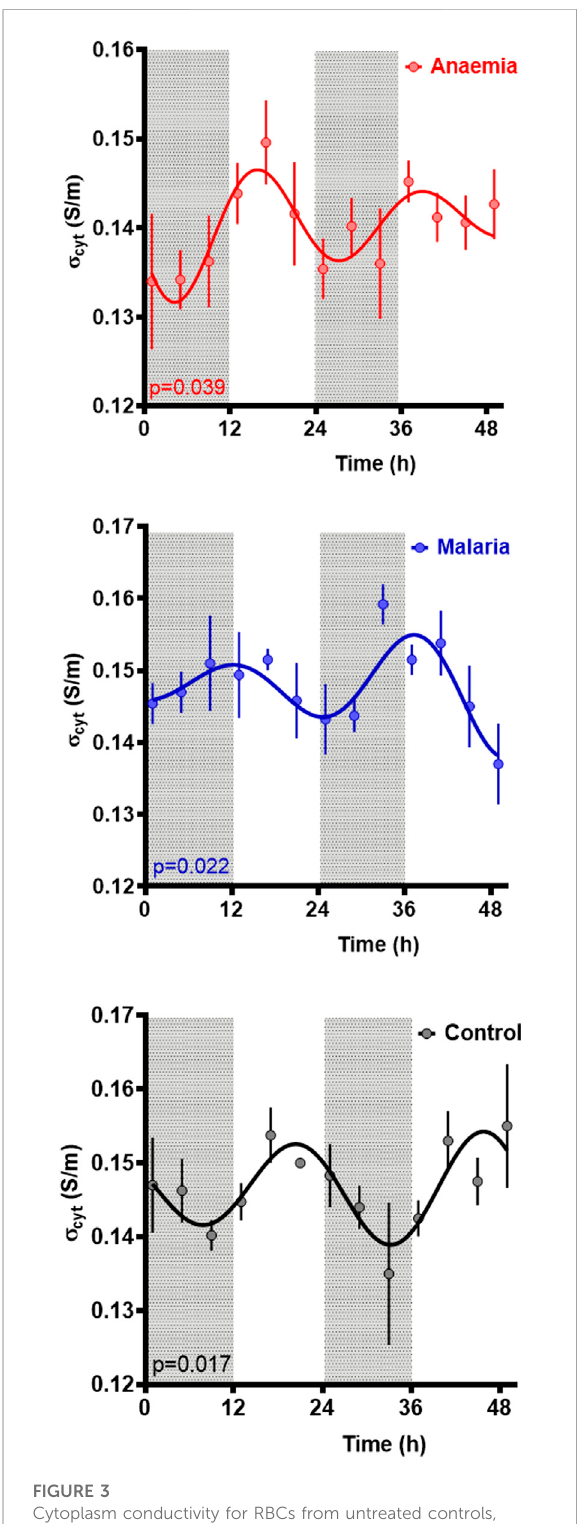
FIGURE 3 Cytoplasm conductivity for RBCs from untreated controls, malaria-infected and anaemic mice. Mean ± SEM and best fi tting models for the cytoplasmic conductivity σ cyto as a function of time since the experiment began, with ZT indicated by light and dark panels. Color-matched curves and lines represent best- fi